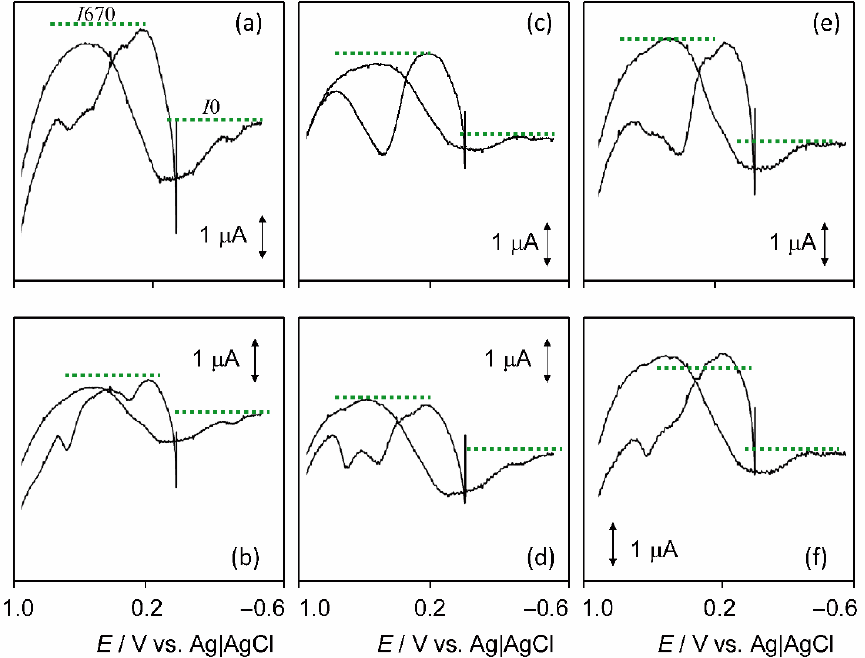
Figure 8. Detail of the region between − 0.6 and 1.0 V vs. Ag/AgCl in cyclic voltammograms, after semi-derivative convolution, of microparticulate deposits of ethanolic extracts of samples from Peru ( a , b ), Pintat ( c , d ) and Ull de Perdiu ( e , f ) cultivars, in control ( a , c , e ) and maximum drought stress ( b , d , f ). From voltammograms such as in Figure 1. The dotted lines mark the baselines used to measure the intensity of 0.67 V ( I 670 ) and 0.0 V ( I 0 ) peak currents, which provide information on the differences between cultivars in relation to ROS scavenging capacity. A higher difference between the ratios I 670 / I 0 of control and stressed plants denotes a higher capacity and, therefore, lower oxidative damage under maximum drought conditions .